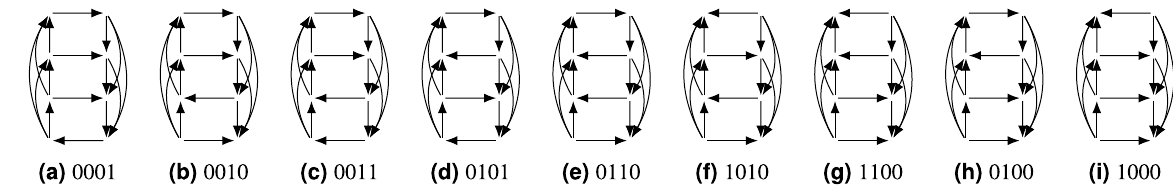
Figure 9. The nine response graphs of generic non-dominated 2 × 4 games. The binary encoding defines the direction of each arc for player 2. ( a , c ) preference-zero-sum, and ( g , i )